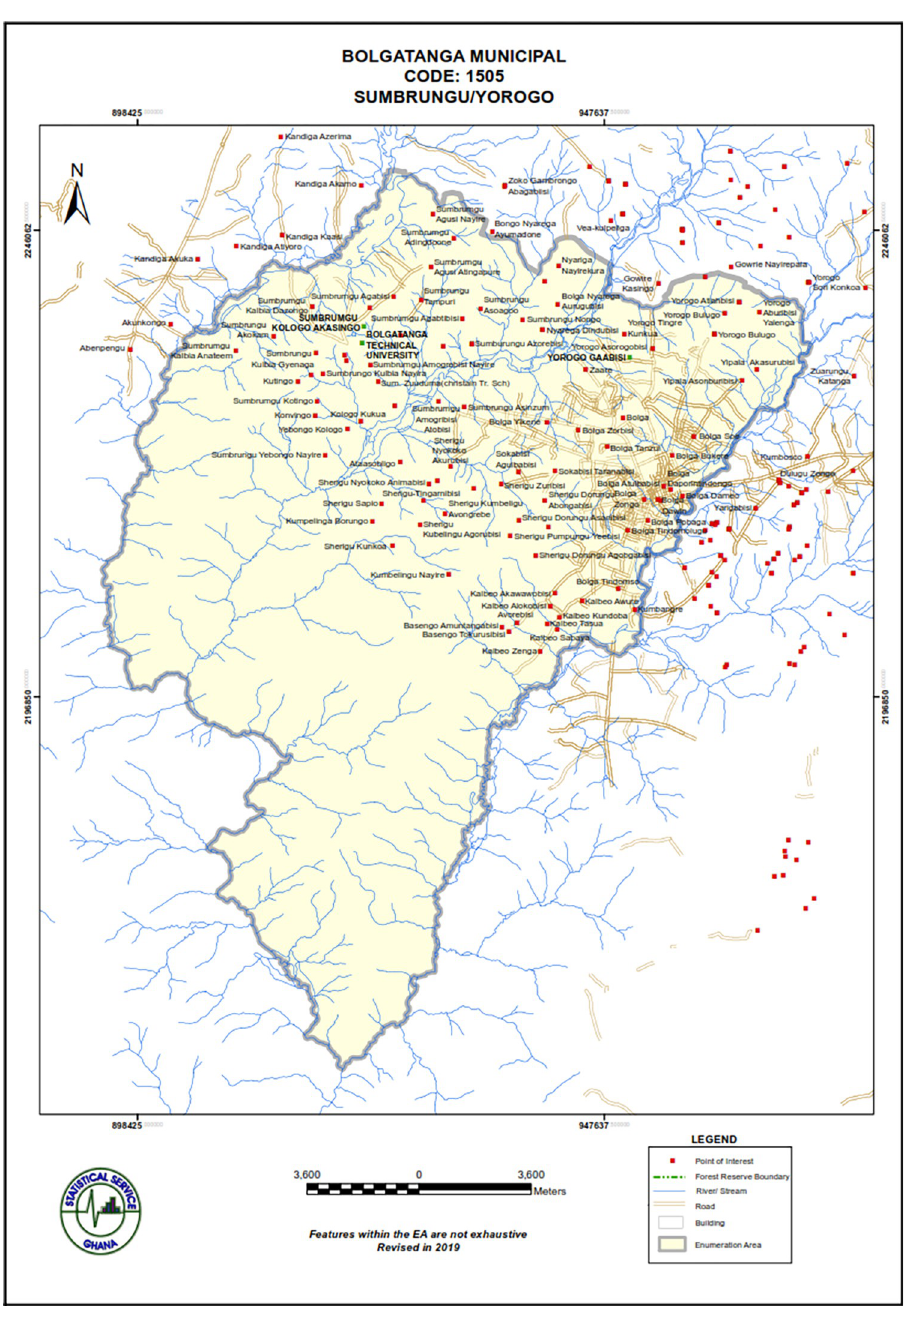
Fig 1. A map of bolgatanga municipal showing Bolgatanga Technical University located in Sumbrungu Kologo Akasingo. Source: Ghana Statistical Service.